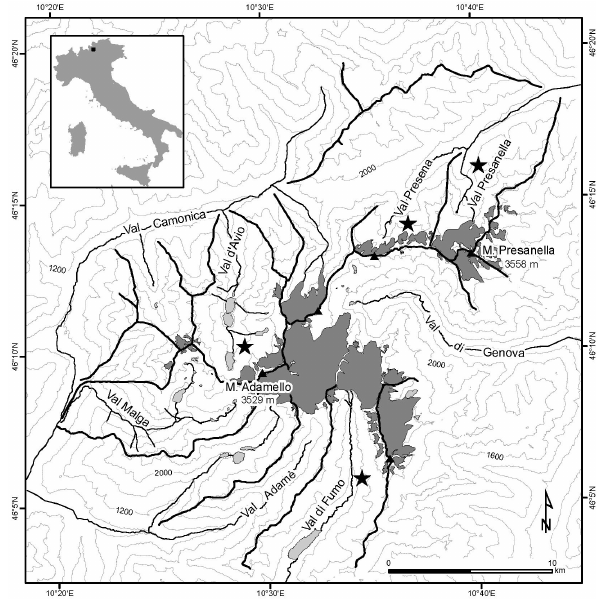
Fig. 1. Sketch map of the study area. Black asterisks indicate the location of the study